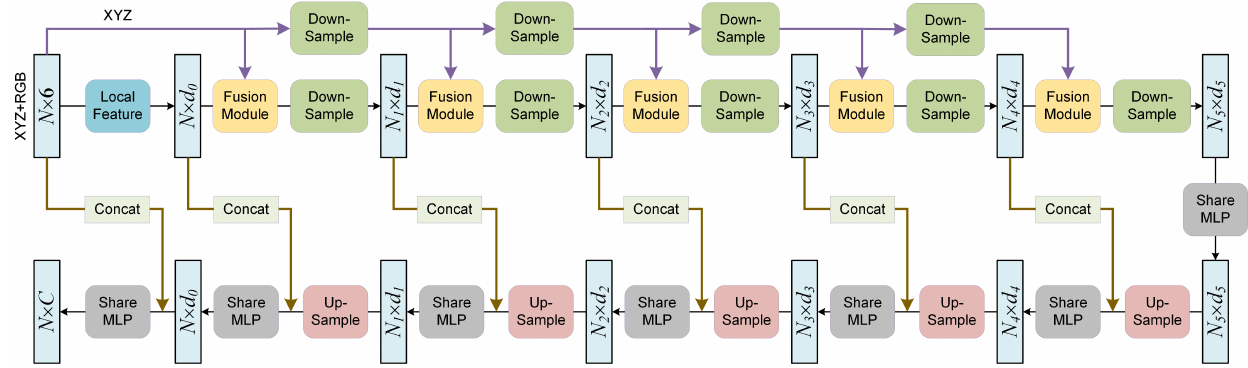
Figure 7. Network architecture for semantic